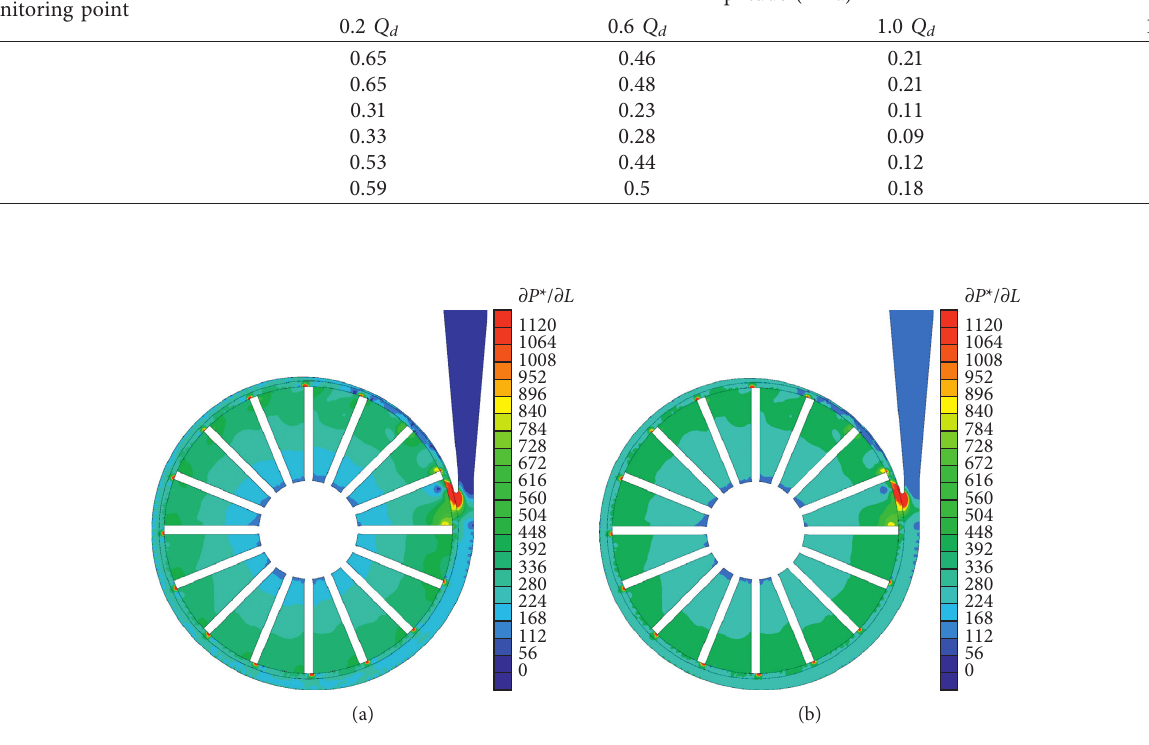
Figure 7: Distribution of static pressure in the central section of the impeller under the flow rate of 0.2 Q (b) at pressure pulsation